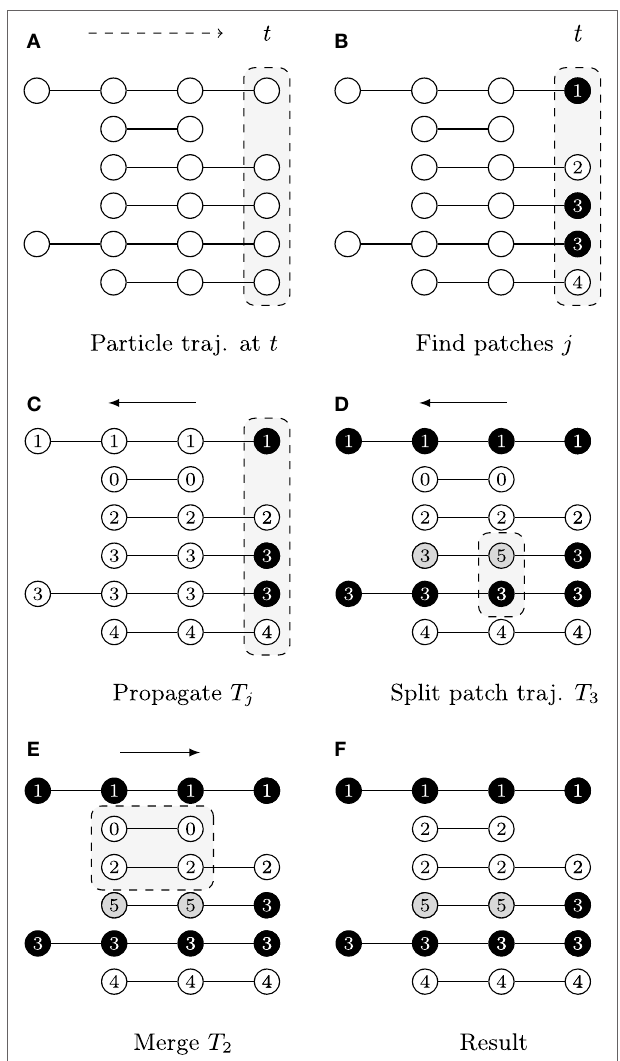
Figure 3 | A graphical description illustrating the patch lineage construction algorithm, where each row shows a temporally coherent particle trajectory that is close to those above and below it in feature space. The dots represent particle positions at each time point and their coloring of white/gray/black represents differences found in feature space provided the user-specified thresholds. The slice of space-time that is the focus of computation in each subfigure is highlighted by gray boxes with dashed outlines. (a) Biomovies have a naturally occurring temporal direction, represented as a dashed arrow ending at time t . The trajectories have a different number of particles, showing that particles can appear at any time point. (B) Particle trajectories are grouped into patches at the last time point. (c) The trajectory information is propagated upstream in a run from the last to the first time point. (D) The split propagation proceeds from the last to the first time point. (e) The merge propagation runs from first to the last time point, mirroring biological growth. (F) The resulting patch lineage contains 5